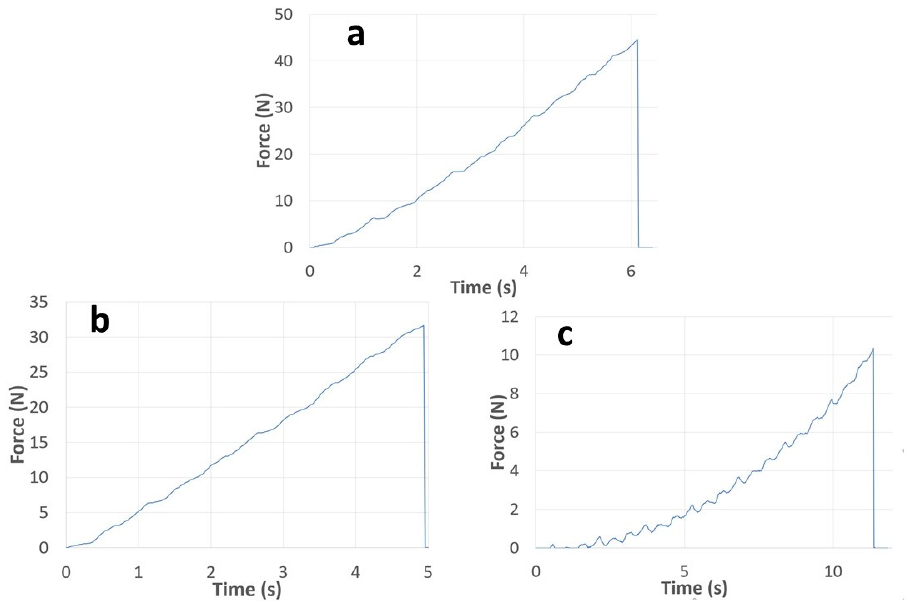
Figure 1. Force–time curves in the case of Ref ( a ), 2% ( b ) and 5% ( c ) concentrations of ascorbic acid.